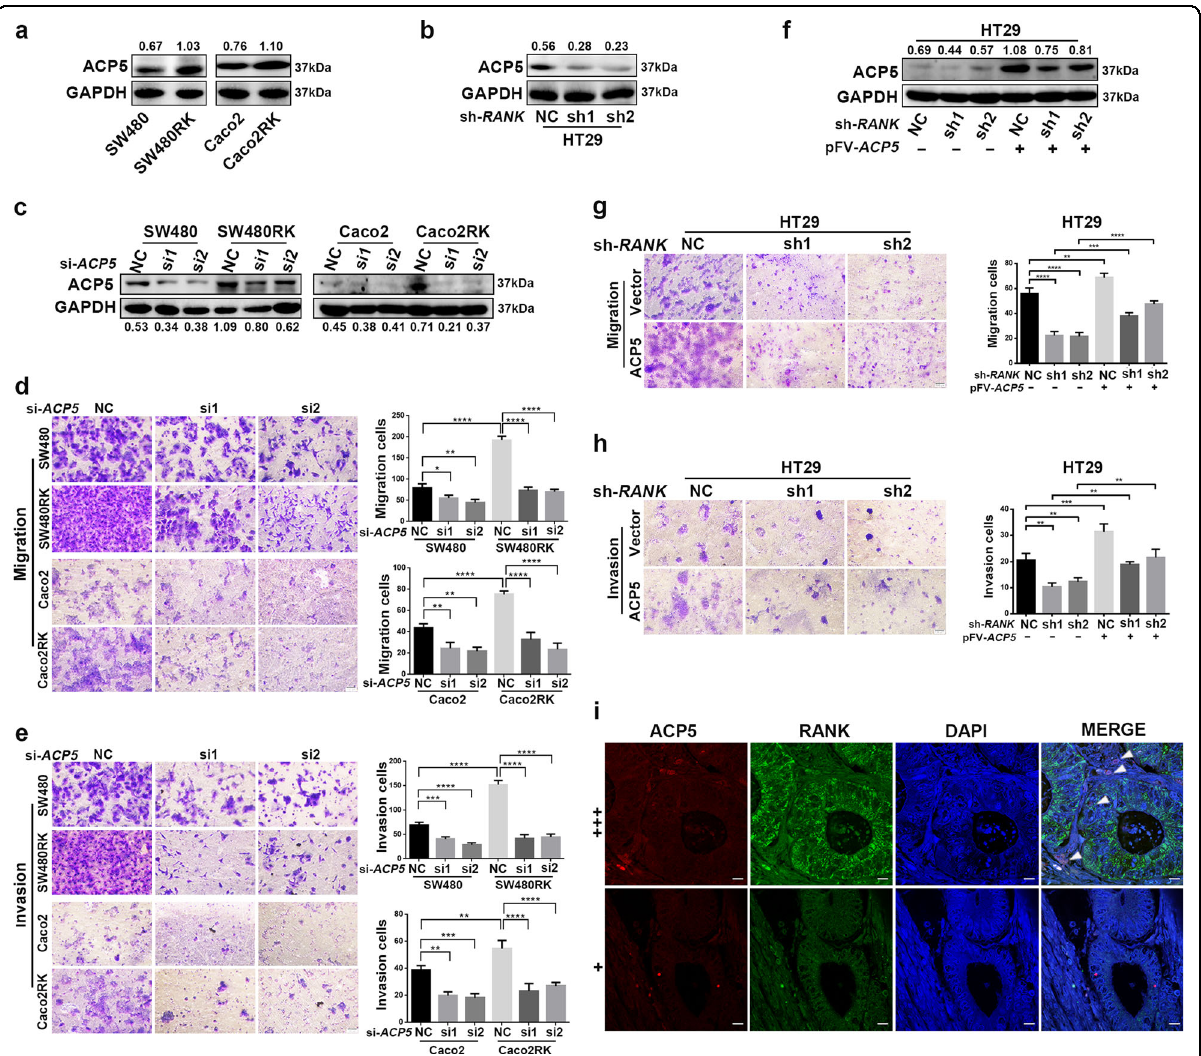
Fig. 3 RANK regulated CRC migration and invasion by activating ACP5 expression. a , b Western blot analysis of upregulation of ACP5 protein in RANK -overexpressing SW480 and Caco2 cells, and downregulation of ACP5 protein in RANK knockdown HT29 cells. c , f Western blotting showed that successful decreased ACP5 protein in RANK overexpression CRC cells transfected with siRNA- ACP5 and increased ACP5 protein by transfection with pFV- ACP5 plasmid in RANK knockdown CRC cells. d , e Knockdown of ACP5 inhibited RANK-induced migration and invasion in SW480RK and Caco2RK cells. Scales bars = 100 μ m. g , h ACP5 overexpression increased migration and invasion of RANK-silencing HT29 cells. Scales bars = 100 μ m. i Representative immuno fl uorescence of ACP5 distribution in high and low RANK expression CRC tissues. Nuclei (blue) were counterstained with DAPI. The white arrowheads indicate ACP5-positive cells are distributed within the tumor and stroma with high RANK expression. + (score 1 – 4), ++ + (score 9 – 12). Scales bars = 10 μ m. Data are mean ± SD ( n = 3). * P < 0.05, ** P < 0.01, *** P < 0.001, **** P <